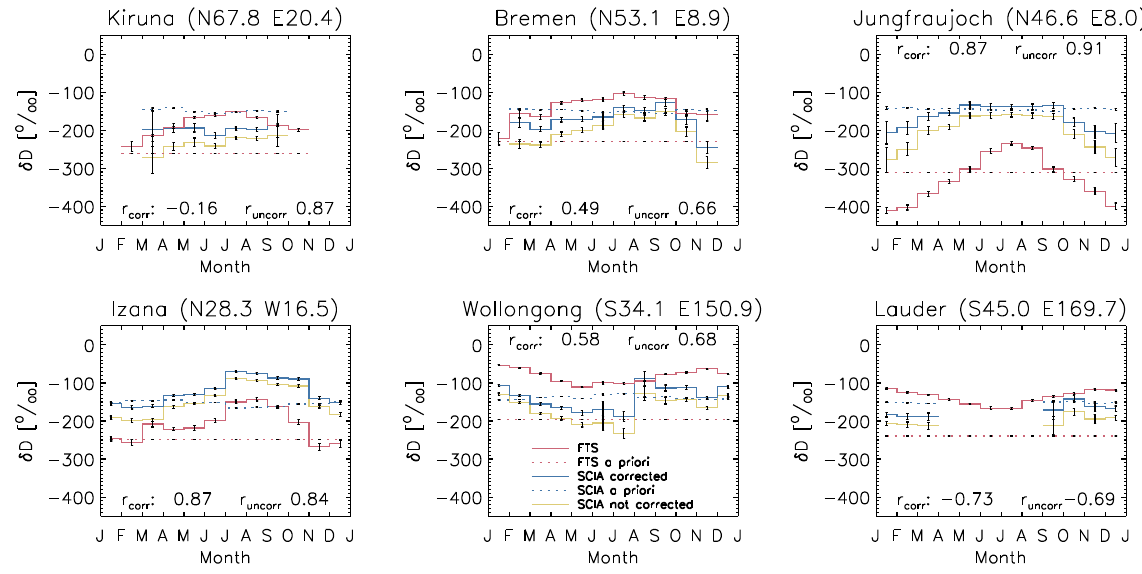
Figure 9. Same as Fig. 8 but for the MUSICA